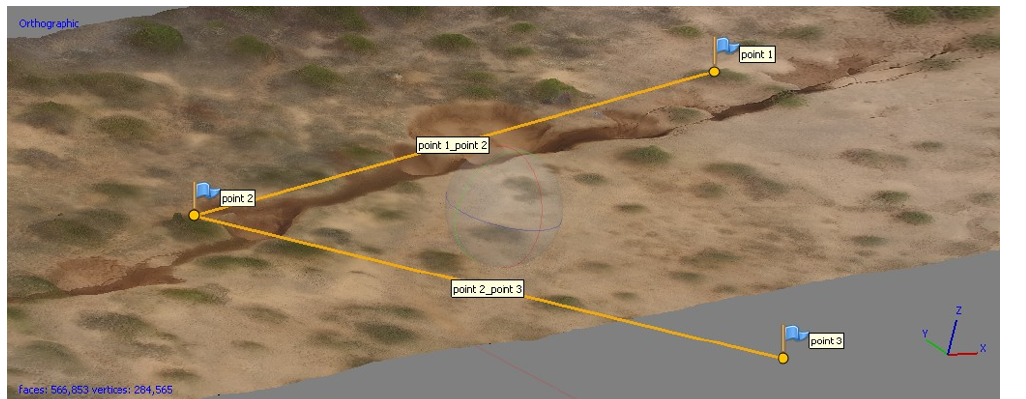
Figure 4. Snapshot of the Agisoft Photoscan software illustrating the insertion of three GCP and their